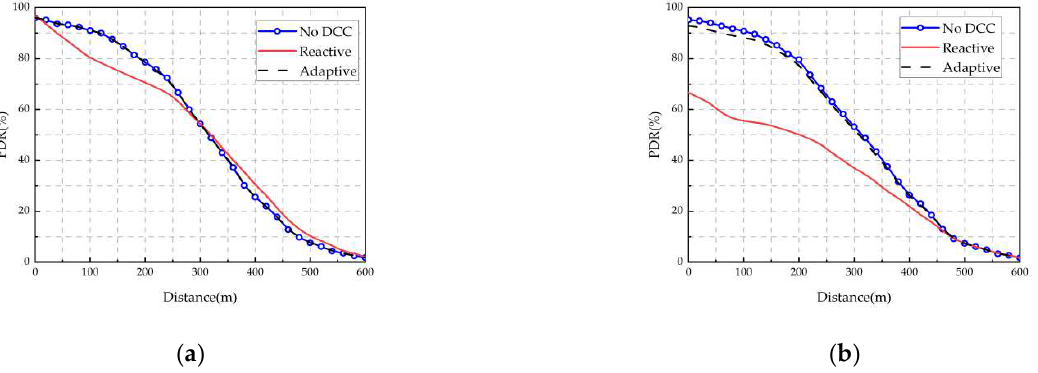
Figure 11. PDR levels for radios and applications with different DCC configurations when all pack- ets have the same priority (DP2). Traffic density:120 veh/km. ( a ) Radio level. ( b ) Application level.